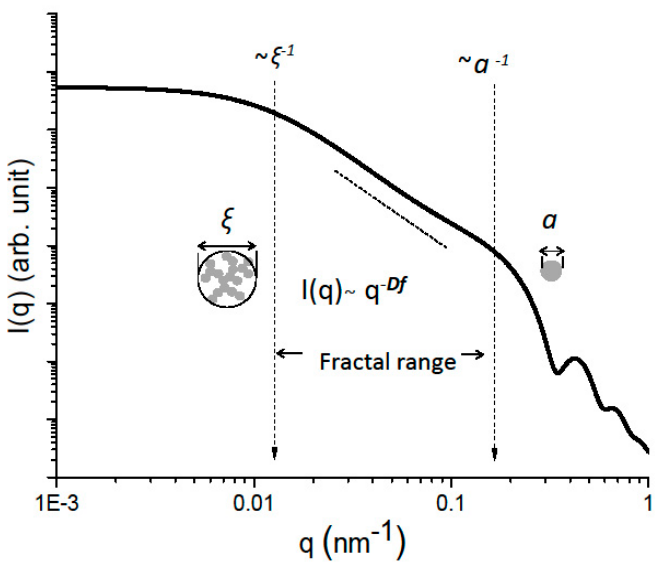
Figure 1. Typical I(q) as measured by SAXS, SANS or USAXS for a fractal aerogel. Fitting the experimental curve with Equation (1) provides an estimate of the fractal dimension Df and of the average correlation length ξ Fitting data from Guinier to fractal regimes. The primary particle size a is deduced from the crossover between fractal and Porod’s